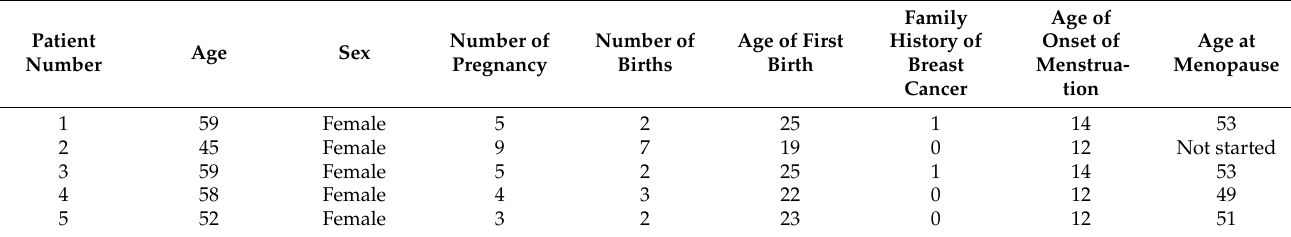
Table 3. Age and demographic details of each patient.